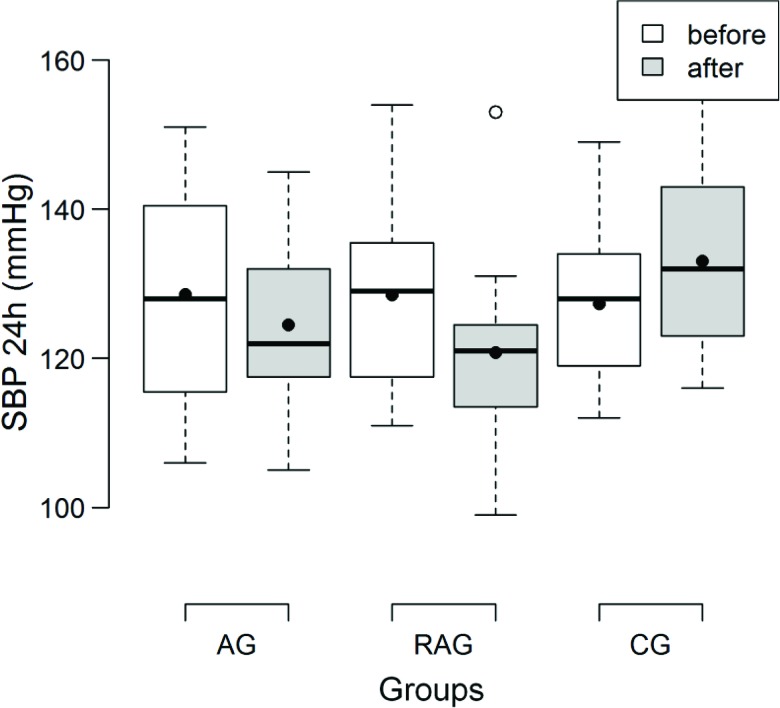
Box plot of the mean systolic blood pressure (SBP) (mmHg) obtained by 24-hour ambulatory arterial blood pressure monitoring before and after all sessions for the aerobic training (AG), resistance and aerobic training (RAG) and control (CG) groups.